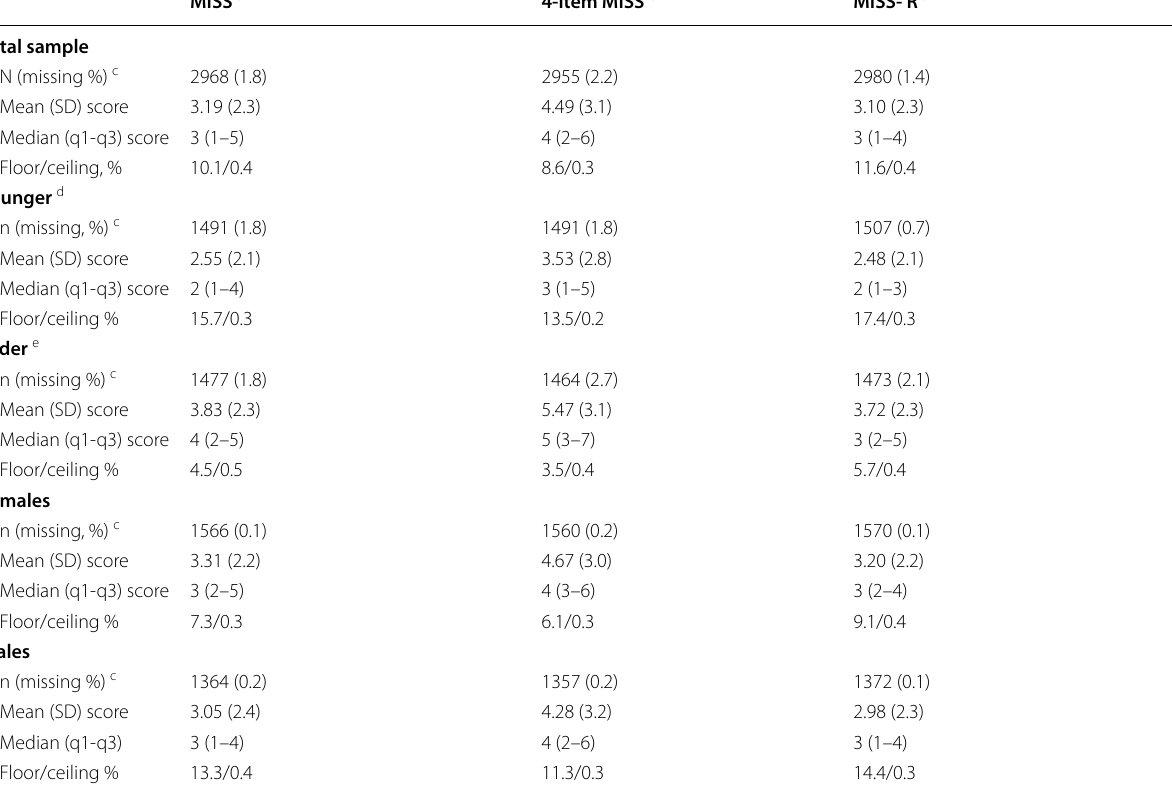
/ceiling effects for the MISS; the four‑item MISS; and the MISS‑R −